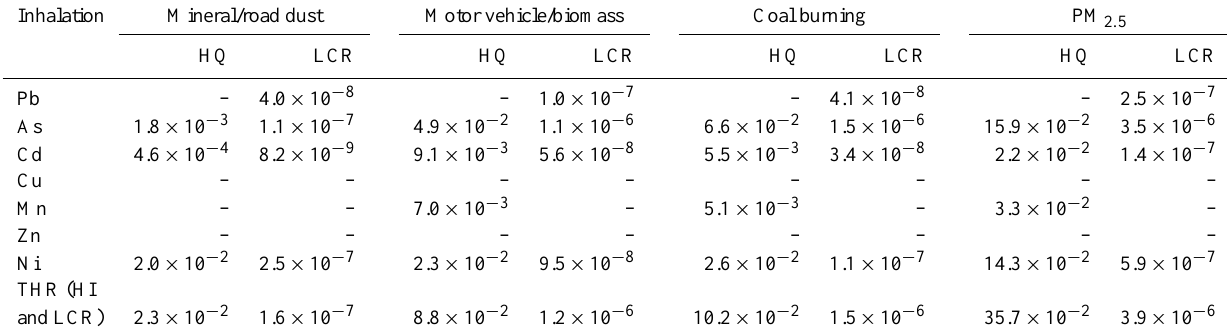
Table 3. Hazard quotient (HQ) and lifetime carcinogenic risk (LCR) for selected heavy metals in PM 2 . 5 associated with sources. Inhalation Mineral/road dust Motor vehicle/biomass